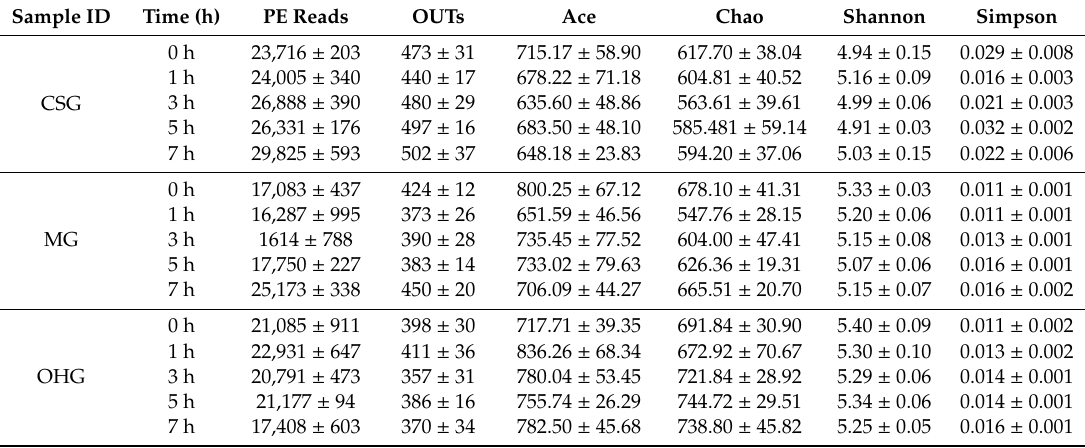
Table 6. Paired-end reads and alpha diversity of sheep rumen fluid bacterial community at di ff erent times. Sample ID